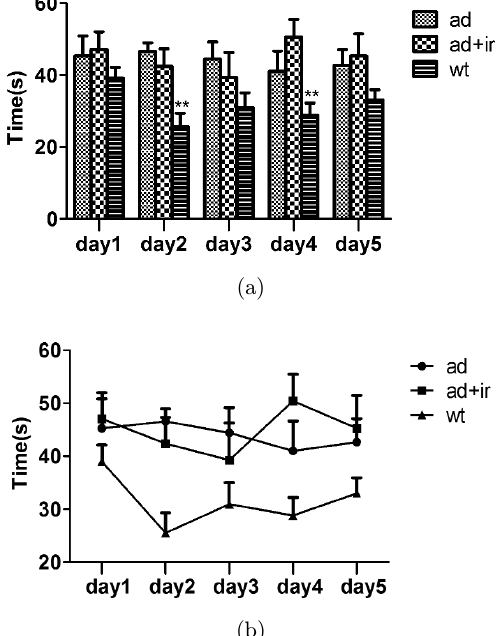
Fig. 2. The results of the second round MWM task. (a) The column graph of second round MWM data. (b) The line chart of second round Morris water data. All data represent means (cid:2) SEM. We compared means of group ad ( n ¼ 8) and wt ( n ¼ 12) with that of group ad þ ir ( n ¼ 6) using a two-way ANOVA followed by LSD post-hoc (* p < 0.05, ** p < 0.01, *** p <